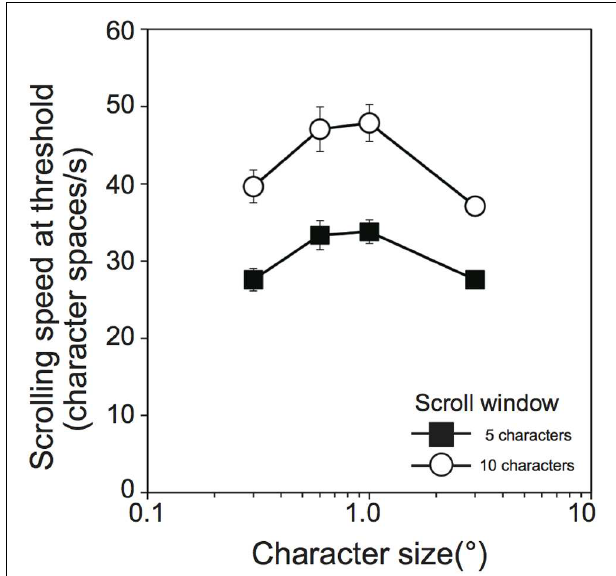
FIGURE 3 | Scrolling speed (character spaces/s) at threshold exposure duration as a function of character size ( ◦ ) in Experiment 1 ( N = 10). Filled squares and open circles indicate scrolling window size of 5 and 10, respectively. Error bars denote the standard error of the